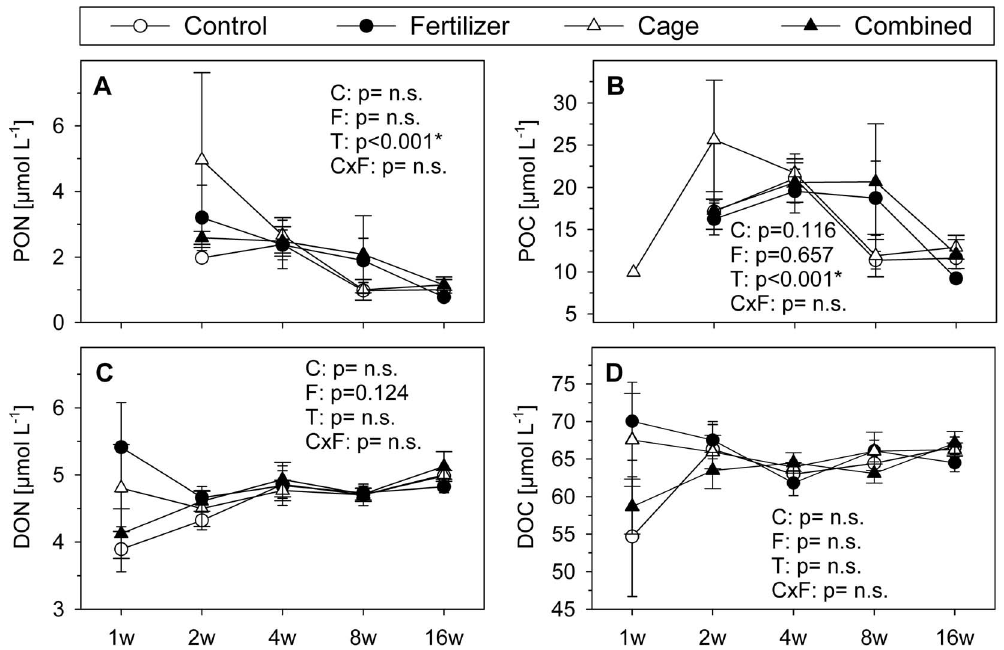
Figure 2. Concentrations of particulate and dissolved organic matter. Particulate (mg cm 2 2 , means 6 SE) and dissolved organic matter concentrations ( m mol L 2 1 , means 6 SE) in water samples taken directly above the installations A: particulate organic nitrogen (PON), B: particulate organic carbon (POC), C: dissolved organic nitrogen (DON), and D: dissolved organic carbon (DOC). Shown are data of all treatments for all 5 sampling times. P-values were calculated from 3-factorial ANOVA and originate from analysis across the whole study period (see Table 1 for full results). Abbreviations: C=Cage, F=Fertilizer, T=Time. Missing values of 1wk for PON and POC resulted from insufficient algal dry mass for analysis. Shown P- values originate from analysis across the whole study period. P-values were tagged as n.s. (=not significant), when the model reduction step excluded the corresponding factor(s). doi:10.1371/journal.pone.0066992.g002 PLOS ONE |